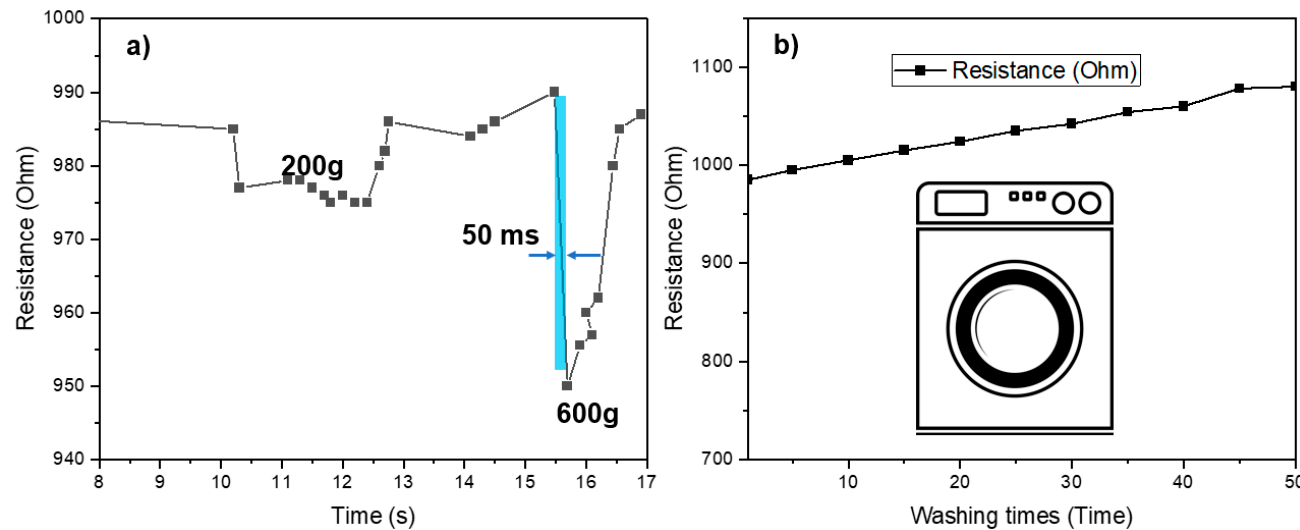
Figure 10. ( a ) Response time. ( b ) The resistance value of conductive nonwoven after 50 washing times.